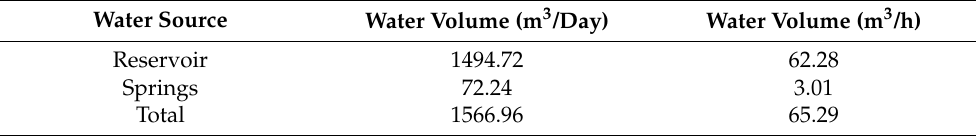
Table 1. Water volume abstracted per water source.